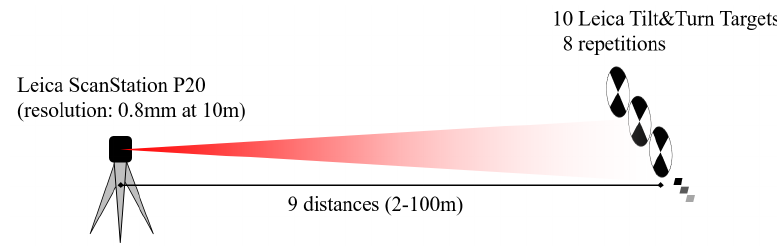
Figure 4. Schematic drawing of the experimental setup for the investigation of the algorithms’ precisions.